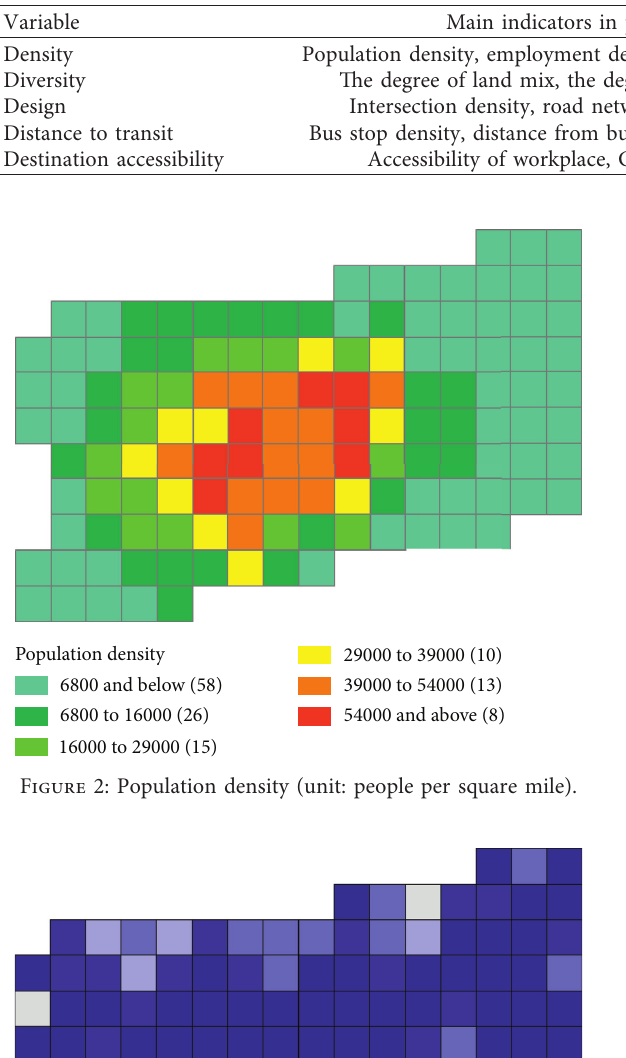
Table 1: The selection of built environment variable.